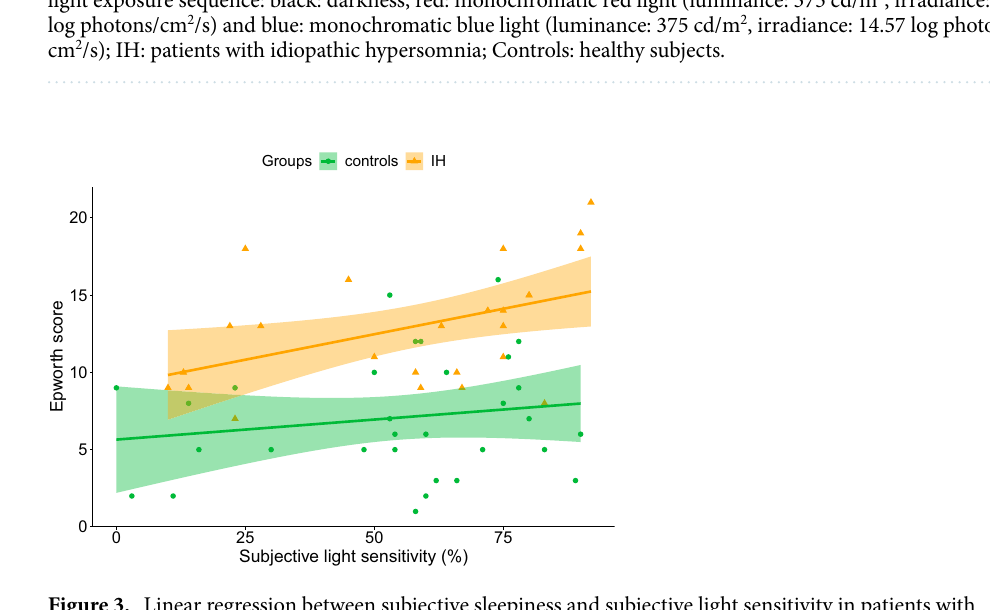
Figure 3. Linear regression between subjective sleepiness and subjective light sensitivity in patients with IH and control subjects. The sleepiness score was obtained using the Epworth scale (ESS) and the subjective light sensitivity was assessed using a Visual Analogue Scale (VAS). The line indicates the association between ESS score and subjective light sensitivity (IH: β = 0.07 ± 0.03, p-value = 0.011; control subjects: β = 0.015 ± 0.03, p = 0.553); IH: patients with idiopathic hypersomnia; Controls: healthy subjects; β: linear regression